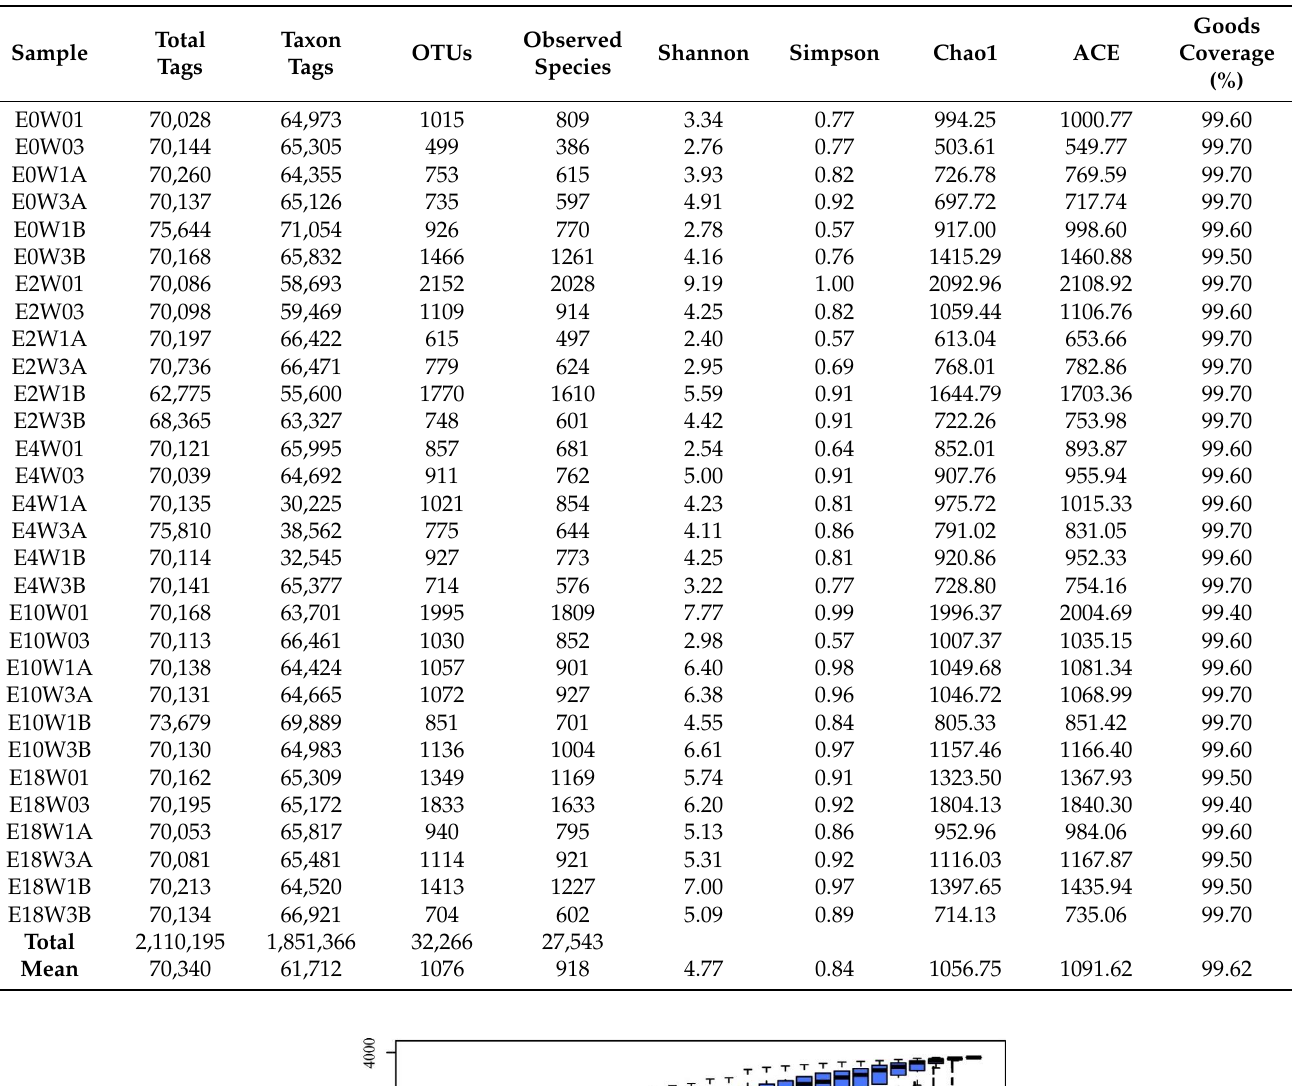
Table 1. The sequencing results of microbiomes in S. palustre in the Erxianyan peatland. Diversity indices and richness metrics are also presented.